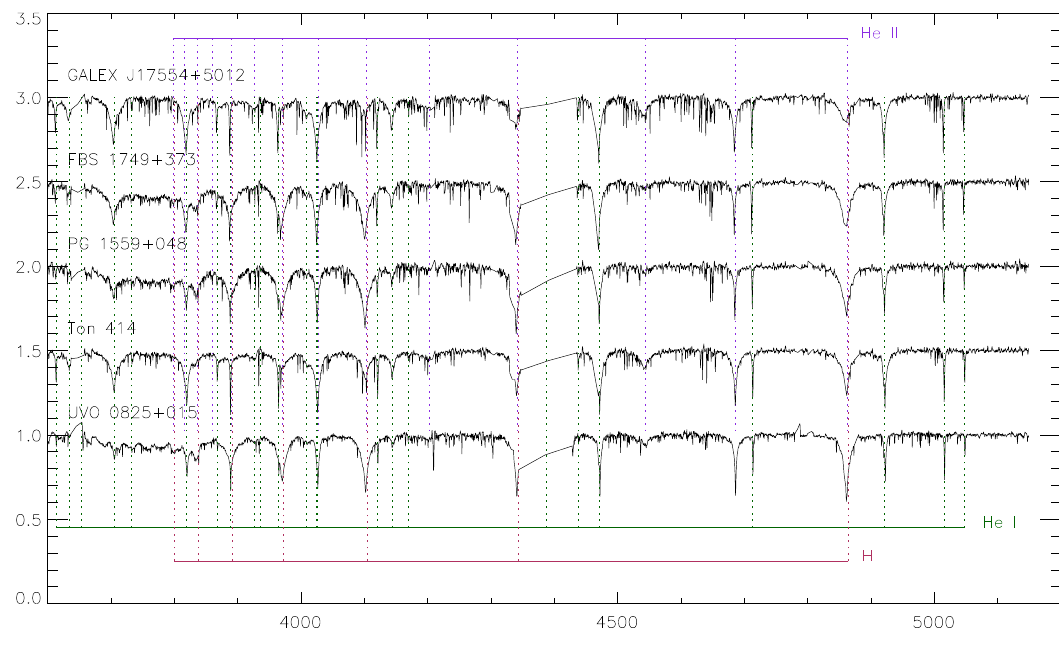
Figure 1. Subaru/HDS atlas of helium-rich hot subdwarfs binned to show major hydrogen and helium lines. Straight lines cover gaps due to CCD defects and the gap between the two